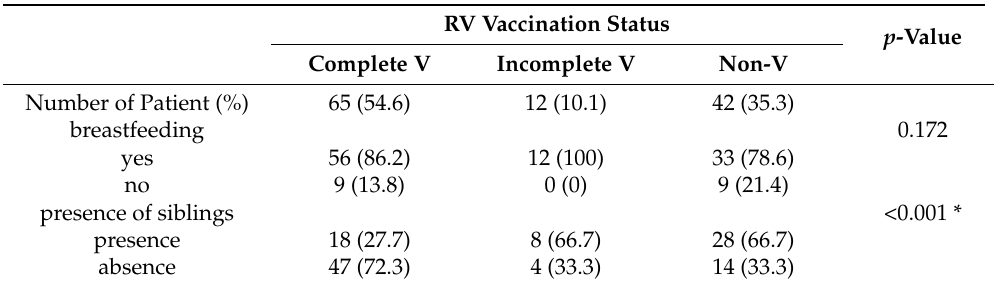
Table 3. Relationship between vaccination history and breastfeeding, and the relationship between vaccination history and siblings in rotavirus gastroenteritis children with hospitalization.